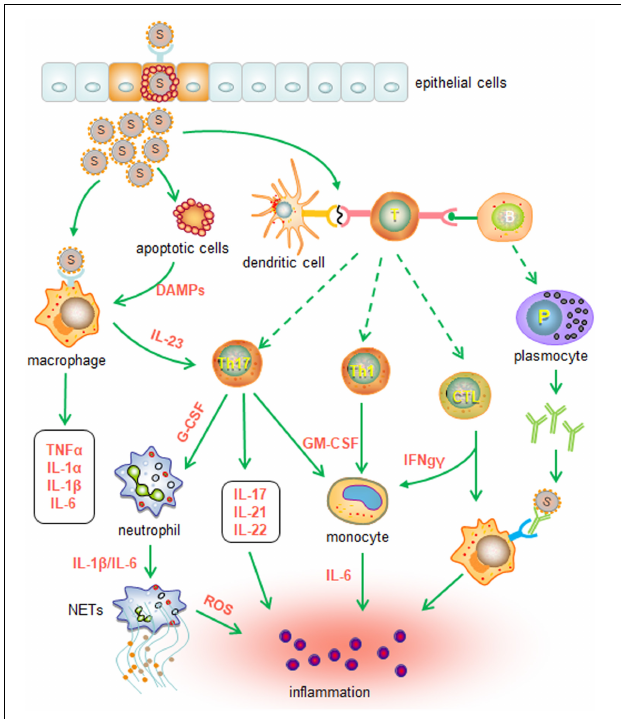
FIGURE 2 | Signaling pathways that are involved in the inhibition of the inflammatory storm by metformin. Metformin directly inhibits complex I activity of the mitochondrial electron transport chain, resulting in an elevated AMP/ATP or ADP/ATP ratio and consequential AMPK activation. Activated AMPK subsequently inhibits the expression of proinflammatory cytokines, such as IL-6 and TNF α , by suppressing the NF- κ B and mTOR signaling pathways. In addition, metformin also inhibits IL-1 β expression and enhances IL-10 expression by macrophages in response to LPS stimulation in an AMPK-independent